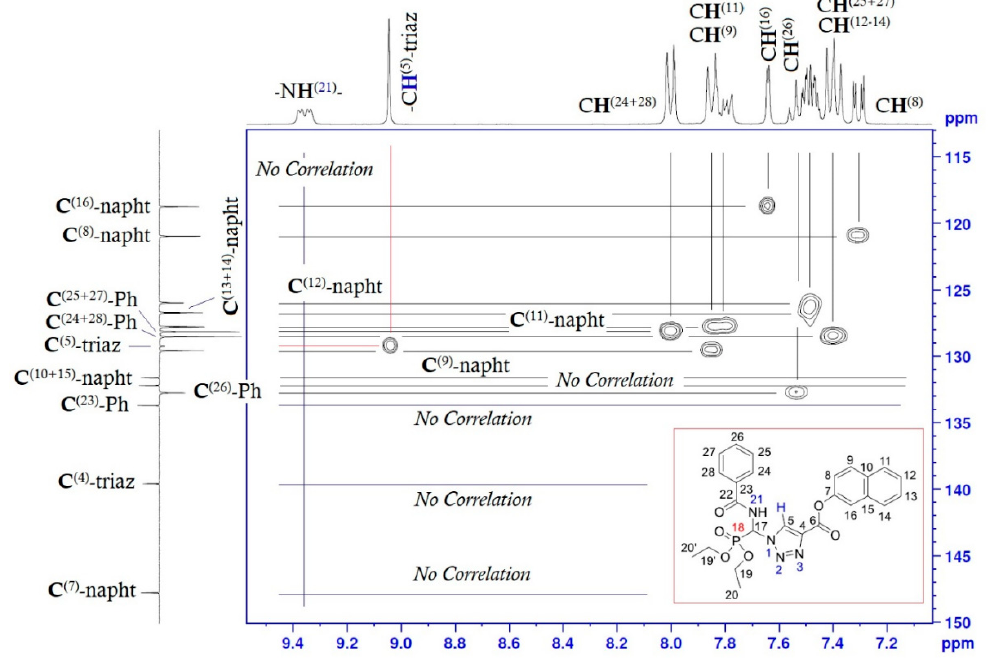
Figure 7. Two-dimensional HSQC spectrum of the cycloadduct ( 3 ) ( Aromatic part ).